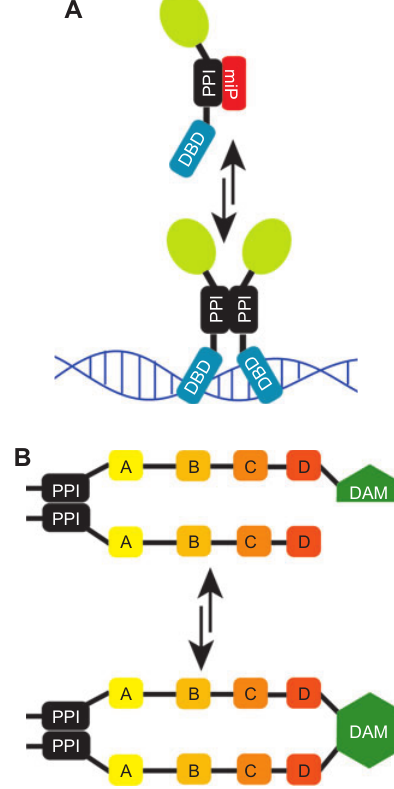
Figure 1 Discrimination between miPs and iPs. (A) miPs consist of a single PPI domain, allowing them to heterodimerize with their targets. It can be assumed that equilibrium between miP-inhibited protein complexes and homodimeric active complexes exists. (B) iP species can be encoded in the genome or produced by alternative splicing. They consist of multiple domains, including a PPI domain allowing them to heterodimerize with their targets. In case the target protein contains a domain, which requires to homodimerize in order to be active [dimeric active motif (DAM)], short iP species can nega- tively interfere with the formation of active protein